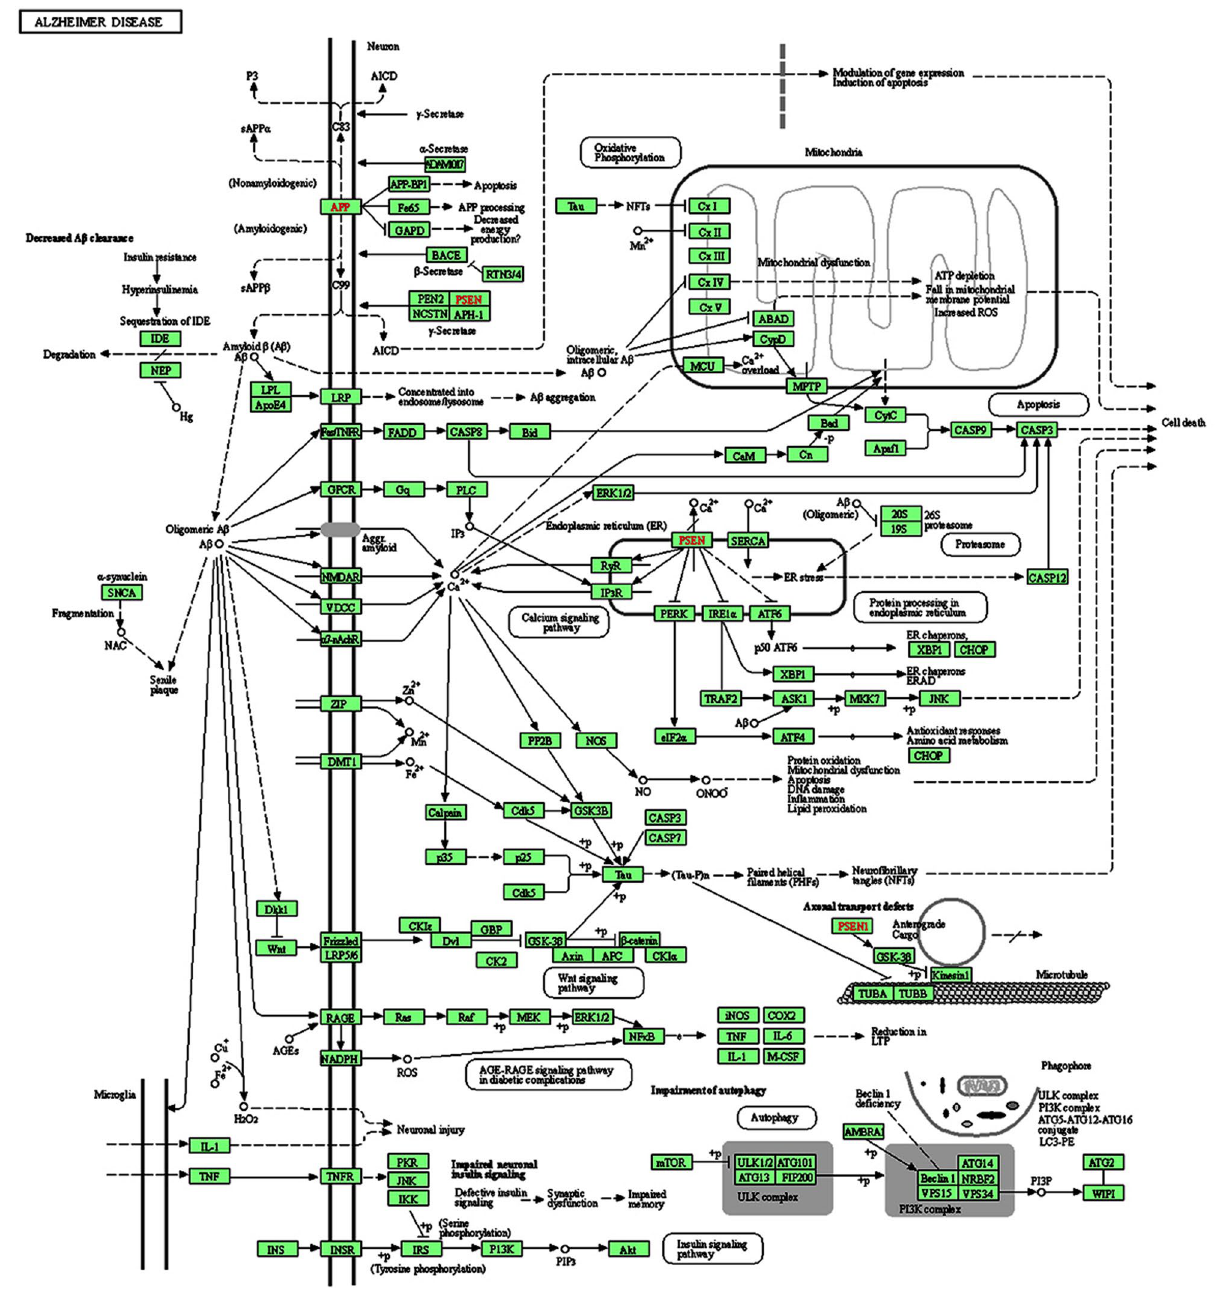
Figure 4. Pathway analysis: The differentially expressed genes (DEGs, 25,000) from wild type, Sirt3 -/- , APP/PS1 and APP/PS1/Sirt3 -/- mouse brain samples were uploaded into the DAVID database (https:// david. ncifc rf. gov/) for KEGG-GO pathway enrichment analysis in APP/PS1/Sirt3 -/- (comorbid-AD) mice. Enrichment analysis of KEGG revealed that DEGs were primarily involved in metabolic, inflammation, Alzheimer disease (AD) and insulin signaling pathways. A representative AD cascade pathway was obtained from KEGG Pathway Maps 19 . For the functional annotation of differentially expressed genes, the web-based DAVID Bioinformatics Resources v 6.8 tool was used (https:// david. ncifc rf.